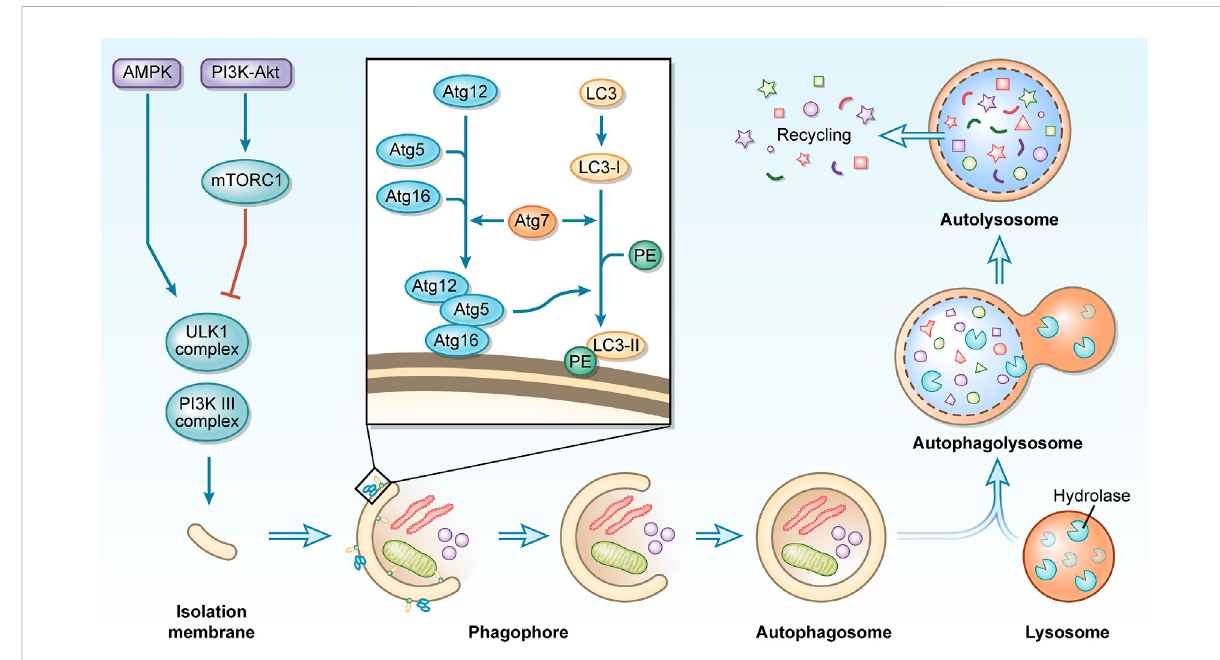
FIGURE 1 A concise description of the macro-autophagy process. During macro-autophagy, cellular components are sequestered in autophagosomes and transported to lysosomes for degradation to achieve recycling